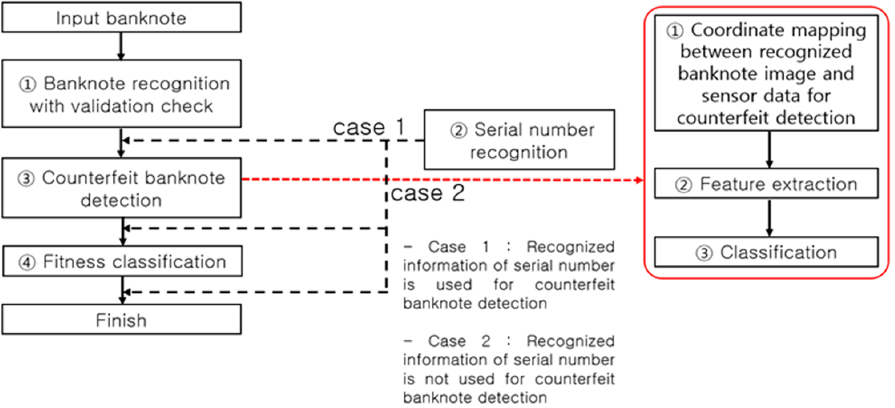
Figure 13. Counterfeit banknote detection process flow.